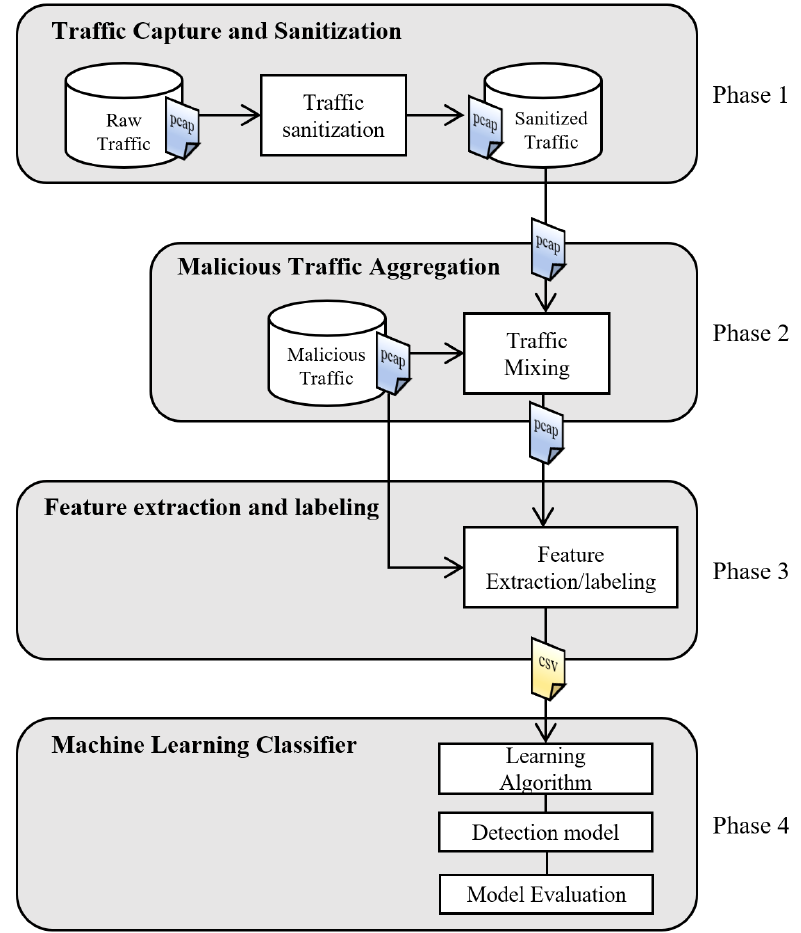
Figure 1. General diagram for the proposal approach.